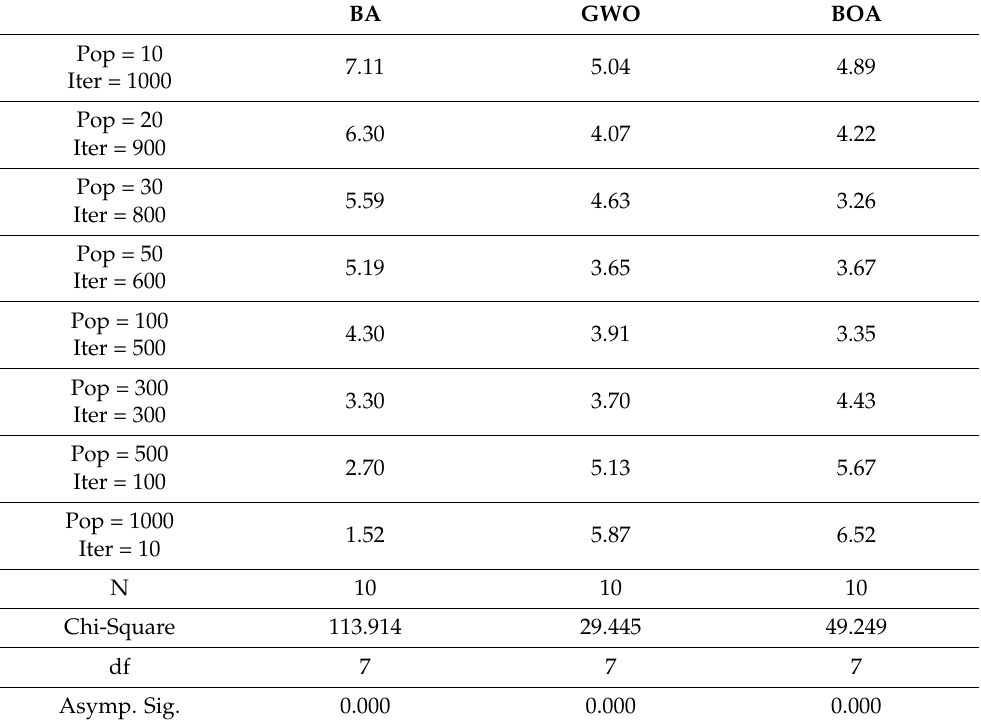
Table 16. Friedman test